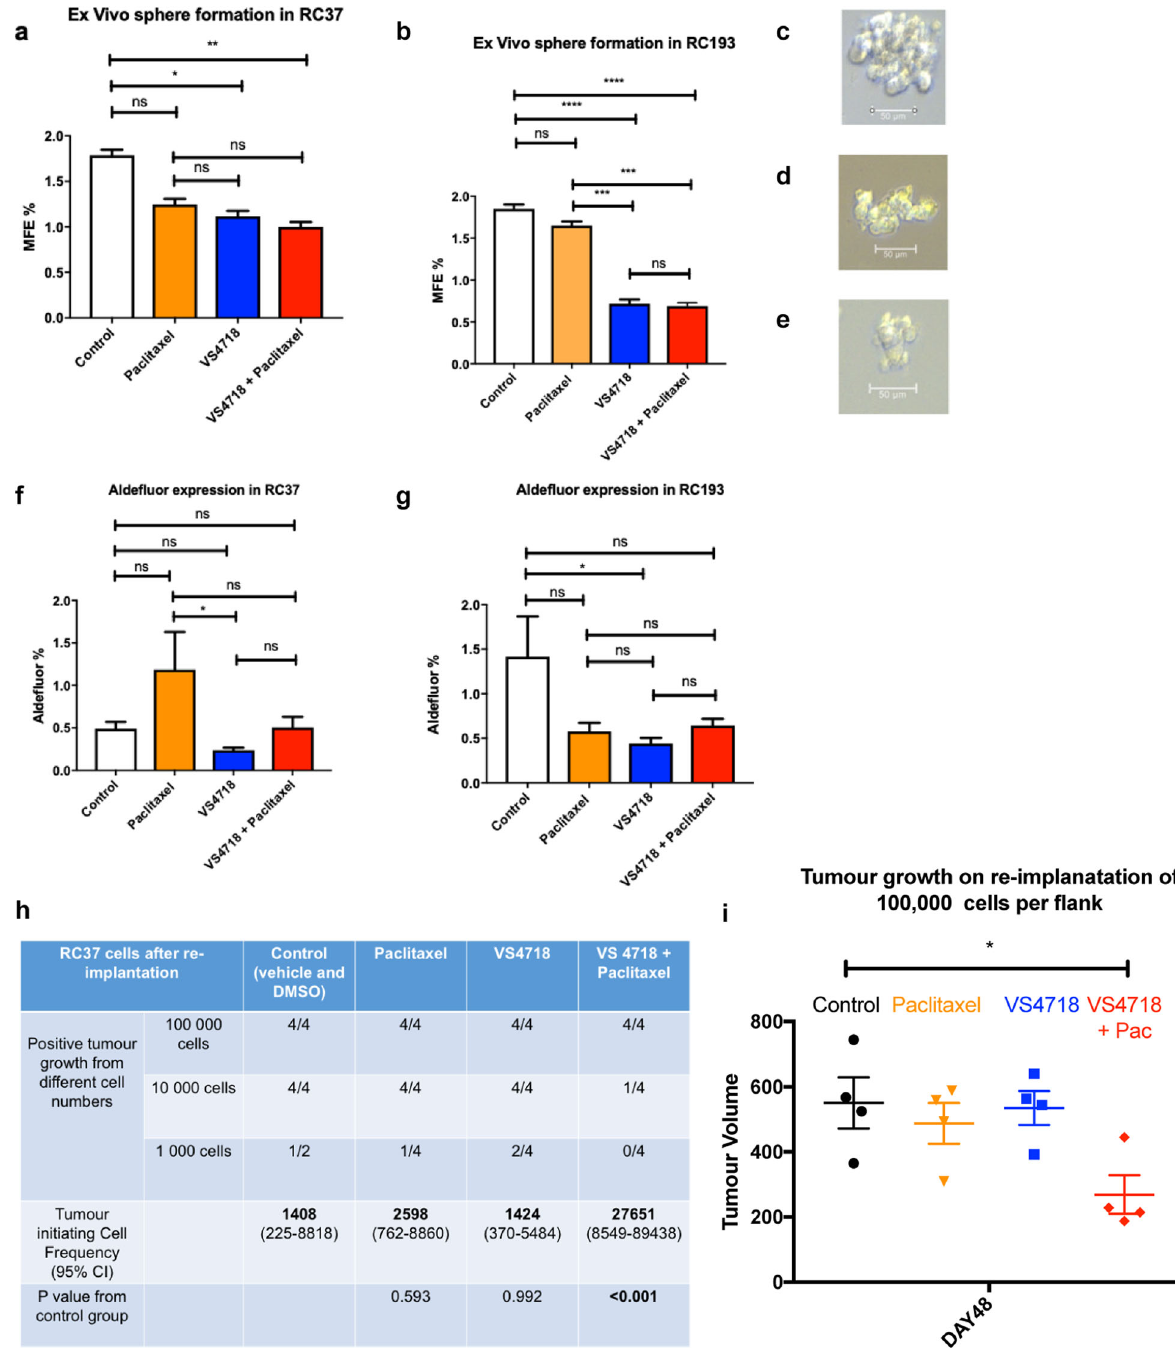
Fig. 6 FAK inhibition reduces ex vivo mammosphere formation, ALDH + expression and tumour initiating capacity. a Graph demonstrating that FAK inhibition reduced ex vivo MFE when used alone or with Paclitaxel in RC37. b Graph demonstrating that VS4718 reduced MFE relative to control and Paclitaxel treated mice in RC193. Photomicrograph taken at ×40 magni fi cation and 50 µM scale bars of mammospheres isolated ex vivo from; c RC37 control group, d RC37 VS4718 treated group, and e RC193 control receiving group. f Graph demonstrating a reduction in ALDH + expression in VS4718 treated mice as opposed to Paclitaxel treated mice in RC37. g Graph demonstrating that VS4718 reduced ALDH + in RC193 relative to control mice. Data in ( a , b , f , and g ) analysed using Two-way ANOVA with post hoc Dunnett ’ s test. h FACS plots demonstrating the identi fi cation of epithelial staining of ALDH was identi fi ed using PDX model. General cells were selected, then live cells isolated using 7AAD. Mouse cells were then excluded using H2KD. For the Alde fl uor assay the DEAB control was set at 0.1%. With ALDH + expression in control mice and VS4718 treated mice in the RC193 model shown in the last two panels. i Limiting dilution table demonstrating that combined FAK inhibition and Paclitaxel treatment led to a reduction in tumour initiating capacity. Tumours were de fi ned based on size greater than 100 mm 3 at Day 60 and ELDA analysis performed using online tool at: http://bioinf.wehi.edu.au/ software/elda. j Combined FAK inhibition and Paclitaxel treatment resulted in a reduction in tumour size in the 100,000 cells per fl ank transplantation on Day 48. Data are represented as mean + SEM. (One-way ANOVA analysis with post hoc Dunnett ’ s test; * p <